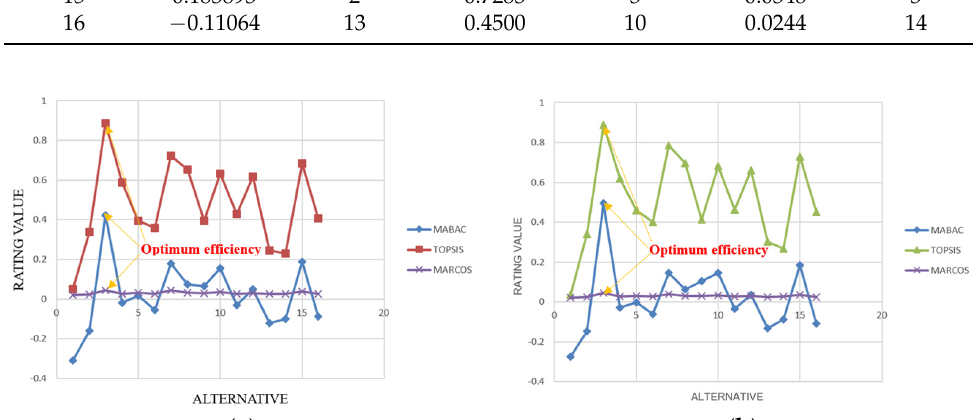
Figure 4. Graph to compare MABAC, TOPSIS, and MARCOS results. ( a ) Entropy weight. ( b ) MEREC weight. Table 6. Priority index and ranking when the weight calculation by entropy method.